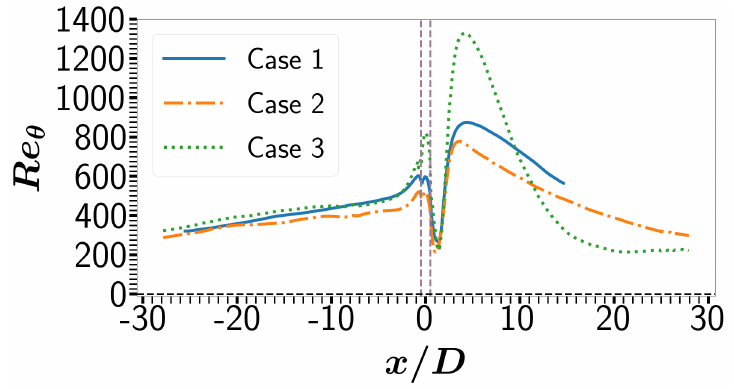
Figure 8. Streamwise variation of Re θ for Case 1, Case 2 and Case